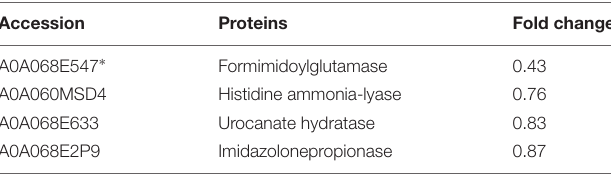
TABLE 2 | Changes in the expression of the proteins involved in the degradation of histidine into glutamate after azithromycin treatment.